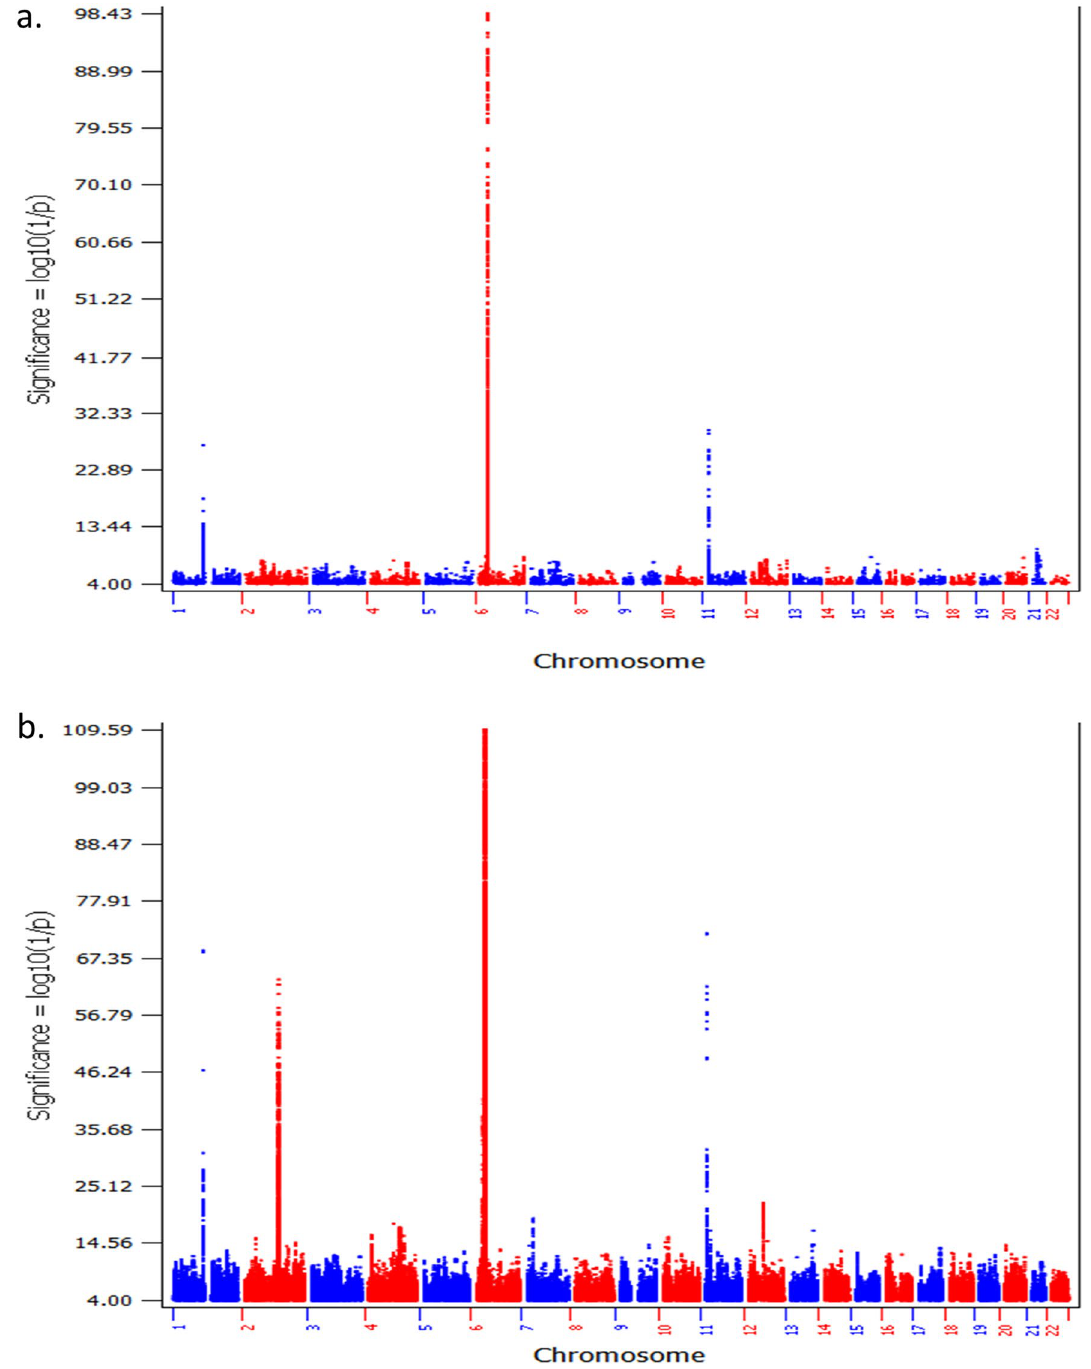
Figure 3. The Manhattan plots of cohort A. ( a ) The plot of the GWAS of T1D patients with low T1D PRS compared to controls with low T1D PRS (907 cases vs. 5567 controls); ( b ) the plot of the GWAS of all T1D patients compared to all controls (3302 cases vs. 6181